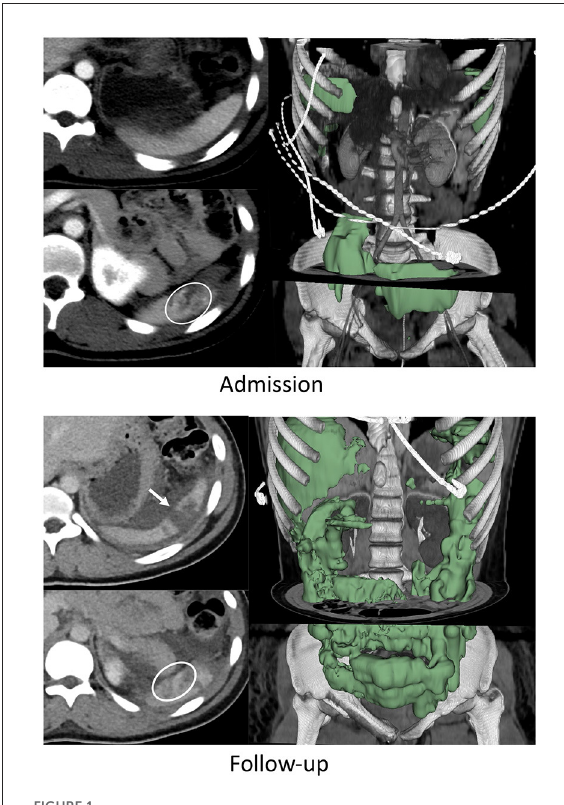
FIGURE1 Nineteen years-old female with BSI who failed AE and underwent splenectomy. On admission CT, the patient had a grade IV BSI with several pseudoaneurysms in the inferior pole of the spleen (circle on bottom left admission CT image), and 253mL of hemoperitoneum. This increased to 1,415mL on follow-up CT performed 49h later (green label mask, right image). Pseudoaneurysms were no longer visualized but the laceration had expanded to include the upper pole (arrow on top left follow up image).